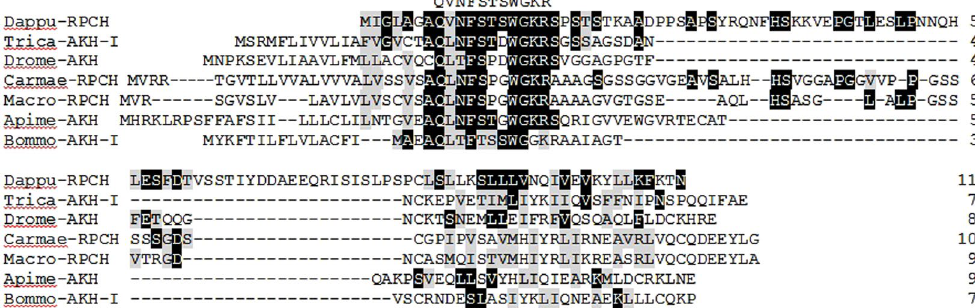
Figure 1. Amino acid sequence alignment of the precursors of Dappu-RPCH (GenBank acc. no. ACJ05605 ), Trica-AKH-I (GenBank acc. no. ABN79648 ), Drome-AKH (GenBank acc. no. NP_523918 ), Carmae-RPCH (GenBank acc. no. AAB28133 ), Macro-RPCH (GenBank acc. no. ABV46765 ), Apime-AKH (GenBank acc. no. AEW68342 ), Bommo-AKH-I (GenBank acc. no. NP_001104825 ). The amino acid position is indicated on the right. Identical residues between the Dappu-RPCH precursor and any of the other precursors are highlighted in black, and conservatively substituted residues in grey. Dashes indicate gaps that were introduced to maximise homologies. Putative transmembrane regions (TM1–TM7) are indicated by grey bars. Abbreviations used: Dappu, Daphnia pulex ; RPCH, red pigment concentrating hormone; Trica, Tribolium castaneum ; AKH, adipokinetic hormone; Drome, Drosophila melanogaster ; Carmae, Carcinus maenas ; Macro, Macrobrachium rosenbergii ; Apime, Apis mellifera ; Bommo, Bombyx mori